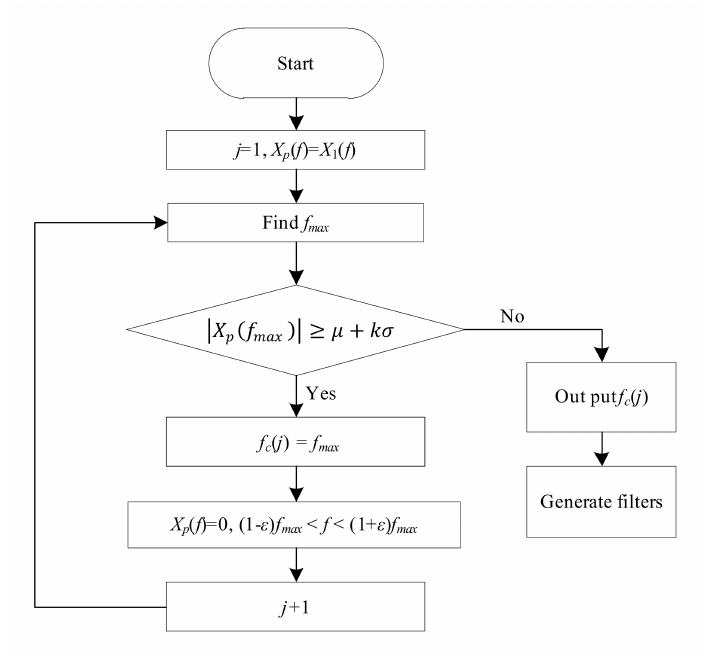
Figure 6. Signal analysis and the generation of band-stop filters in practical